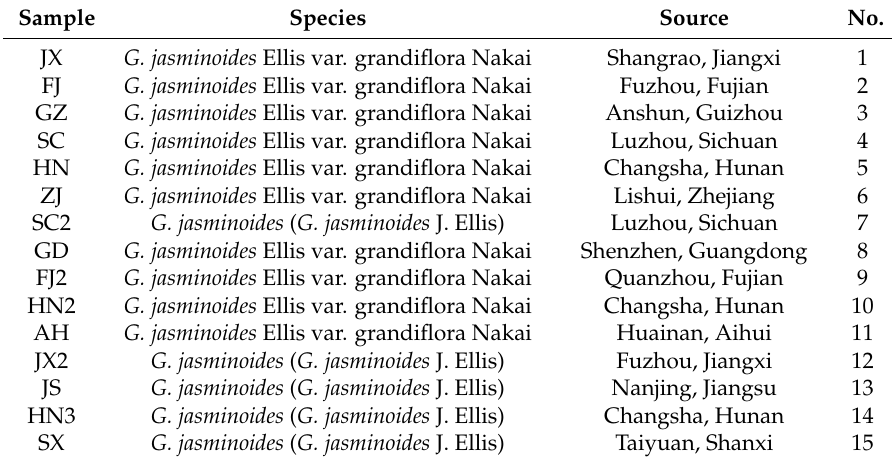
Table 1. Sources of RAPD-SCAR samples for cultivars of G. jasminoides Ellis var. grandiflora Nakai and G. jasminoide